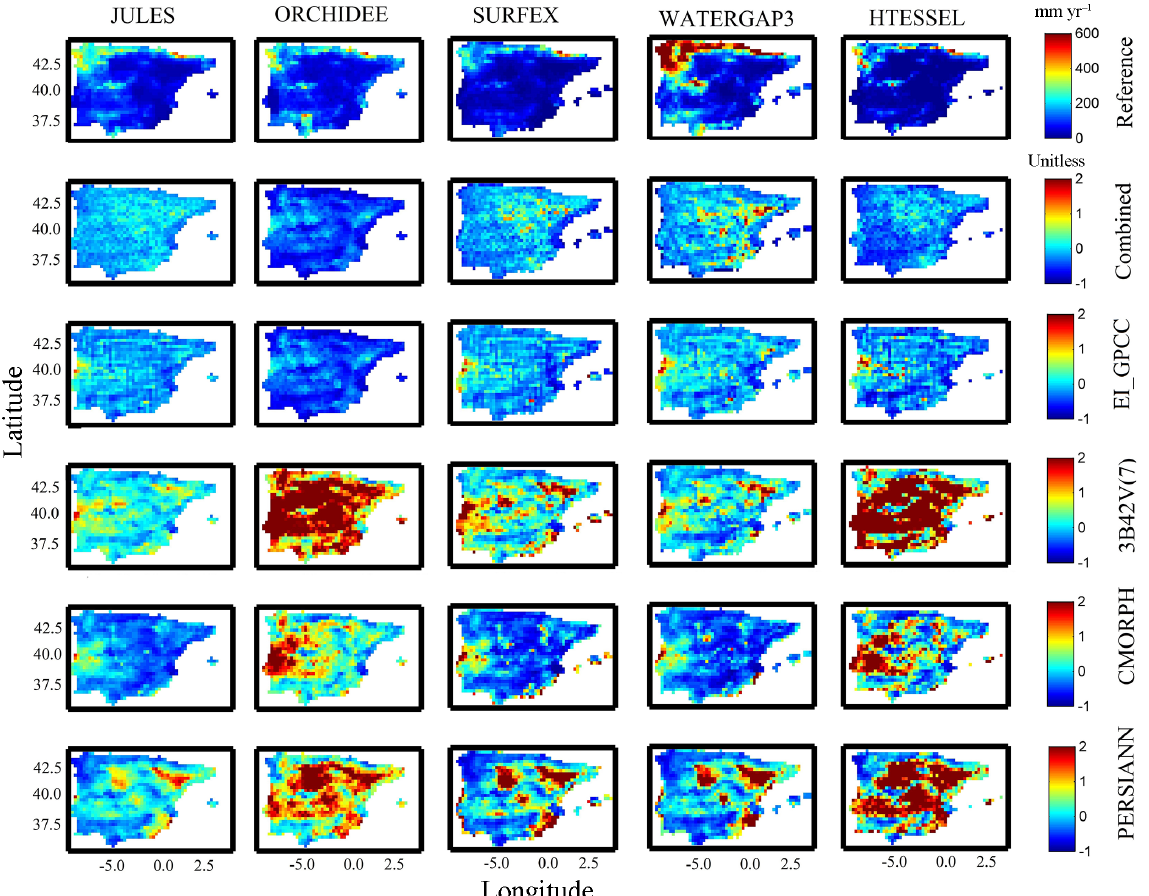
Figure 3. Map of SAFRAN-based simulations (Reference) of surface runoff (top row), and relative difference for the various models (columns) and precipitation forcing (rows 2–5)